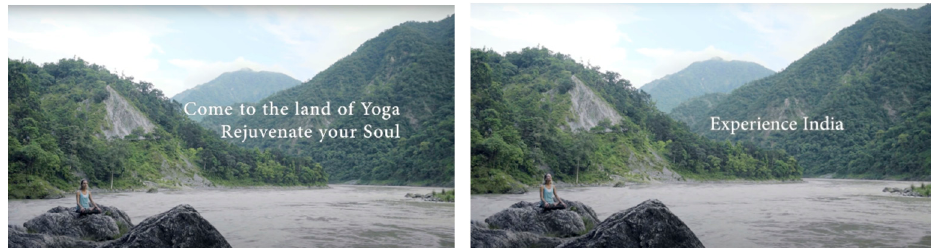
Figure 2. Still images from yoga tourism campaign by Incredible !ndia (2017).